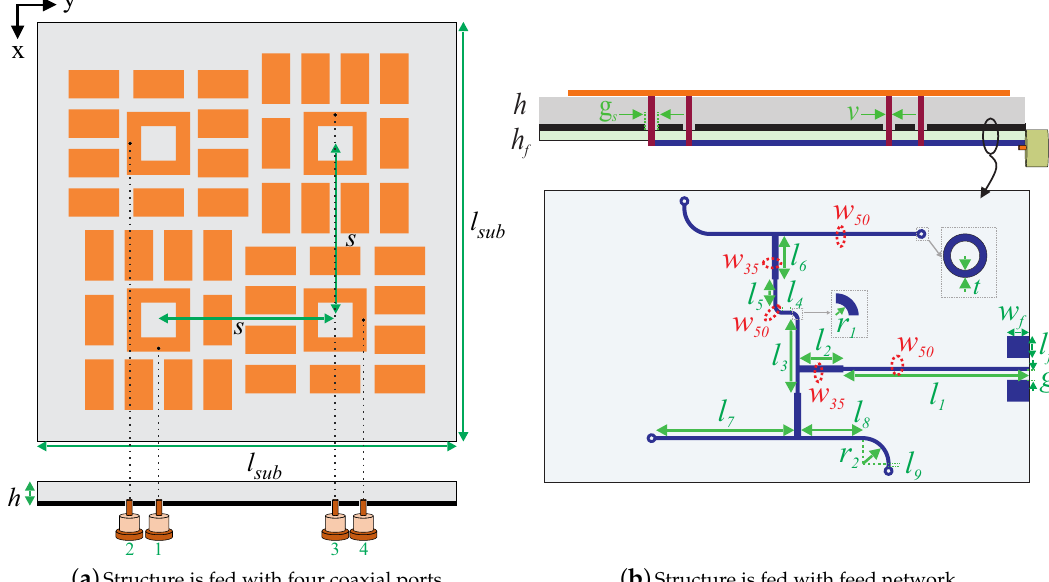
Figure 4. 2 × 2 square ring elements embedded within metasurface and excited with ( a ) four coaxial probes, and ( b ) feed network. The feed network parameters are: l 1 = 50.875 mm, l 2 = 12 mm, l 3 = 20 mm, l 4 = 2.25 mm, l 5 = 7.2 mm, l 6 = 11.9 mm, l 7 = 37.87 mm, l 8 = 16.92 mm, l 9 = 0.69 mm, w 50 = 1.1 mm, w 35 = 1.9 mm, g s = 2.74 mm, v = 1.143 mm, w f = l f = 6 mm, g f = 2.45 mm, r 1 = 1.4 mm, r 2 = 6.5 mm, and t = 0.79